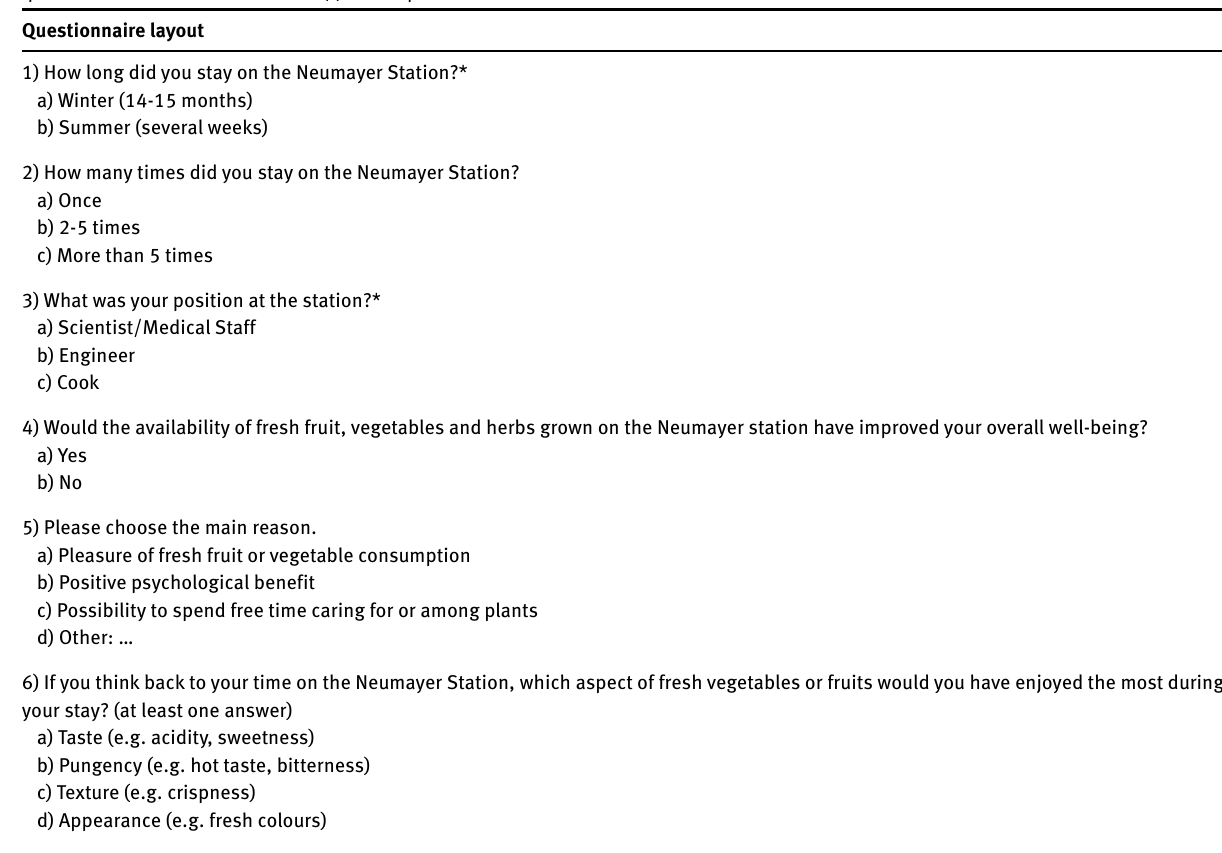
Table 1: Questions asked in the survey. For each question respondents had to choose one answer (letter) unless otherwise stated. To questions marked with an asterisk (*) the respondent could add a